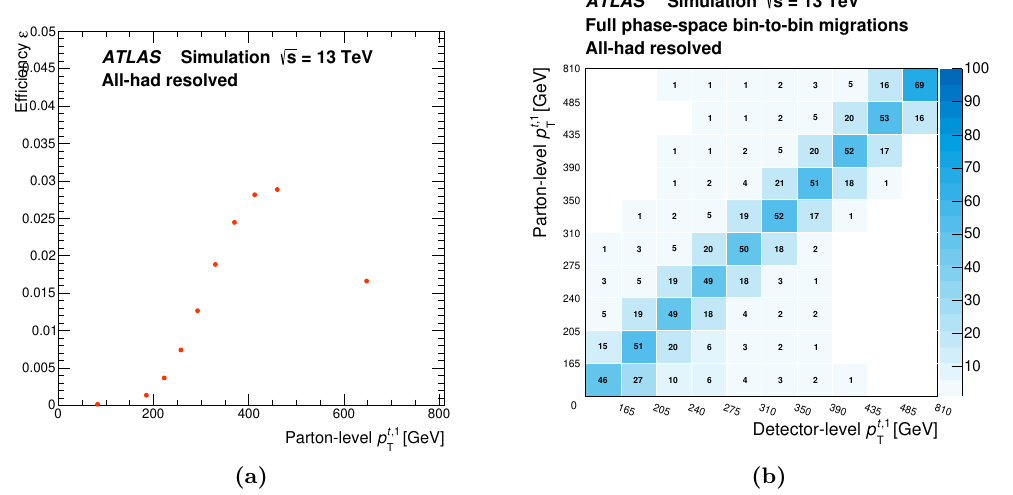
and (b) parton-to-detector- T is identically 1 and is not acc